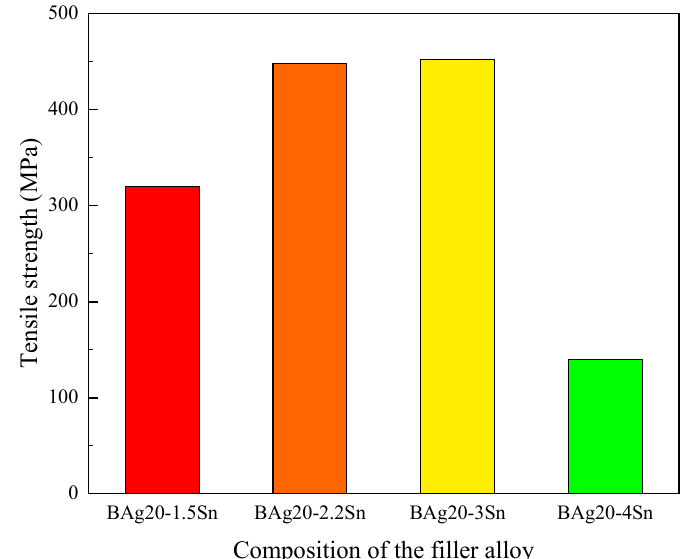
Figure 10. Tensile strengths of stainless steel/stainless steel joints brazed by using Ag-Cu-Zn filler metals with different contents of Sn [22].